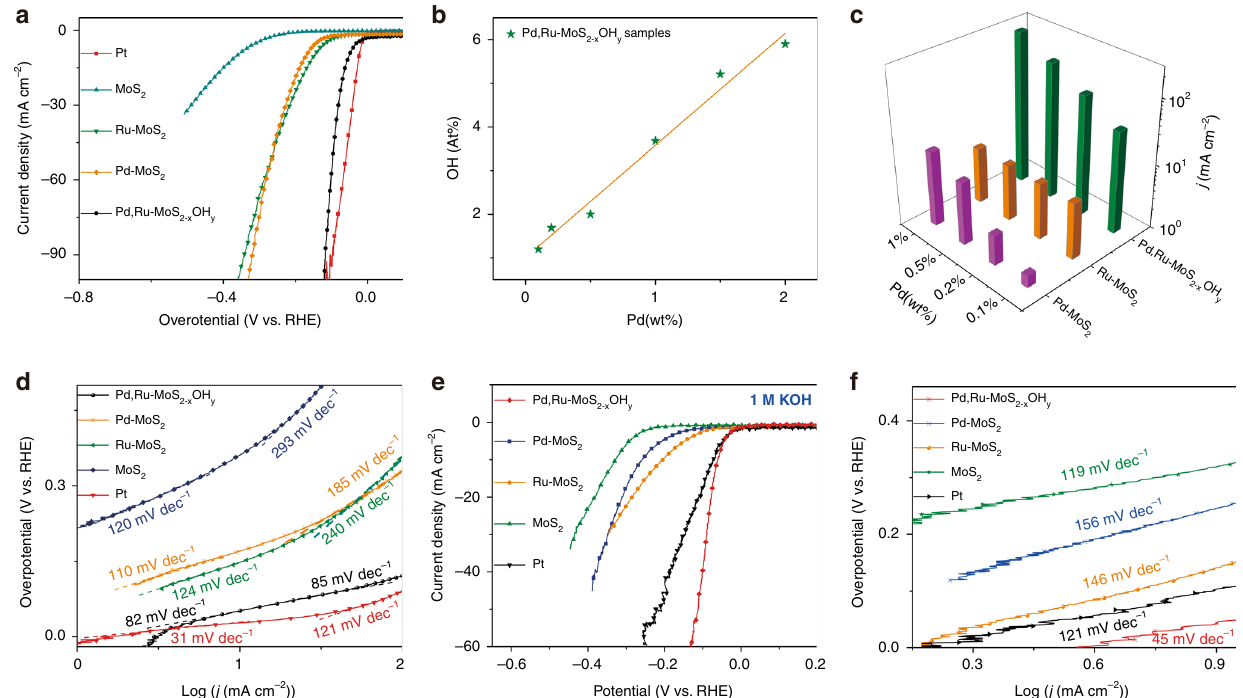
Fig. 2 Superior activity and stability of Pd, Ru – Mo 2 − x OH y . a LSV polarization curves of Pt, MoS 2 , Ru – MoS 2 , Pd – MoS 2 and Pd, Ru – MoS 2 − x OH y in 0.5 M H 2 SO 4 . (with iR correction). b OH content as a function of Pd content in Pd, Ru – MoS 2 − x OH y c Current density achieved at η = 140 mV as a function of Pd content in Pd, Ru – MoS 2 − x OH y , Ru – MoS 2 , and Pd – MoS 2 . d Tafel plots derived from the results given in a . e LSV polarization curves of Pt, MoS 2 , Ru – MoS 2 , Pd – MoS 2 and Pd, Ru – MoS 2 − x OH y . (with iR correction) in 1 M KOH. f Tafel plots derived from the results given in e